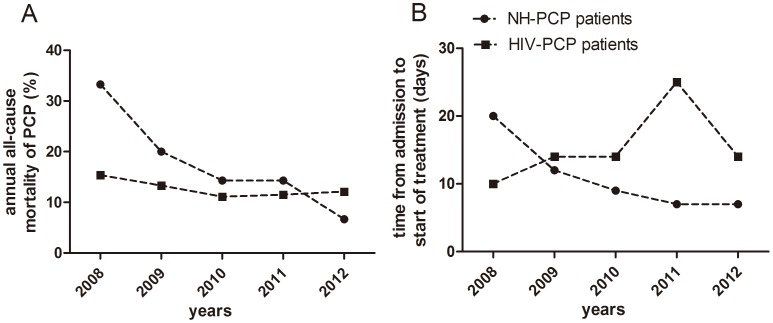
The annual outcome.From 2008 to 2012, all-cause mortality in NH-PCP patients showed a declining trend, but the annual trend of HIV-PCP patients was almost flat. (A).Time from admission to start of treatment in the NH-PCP group showed the same trend as all-cause mortality, but in the HIV-PCP group the trend was not obvious. (B). The results are reported as median and rate.